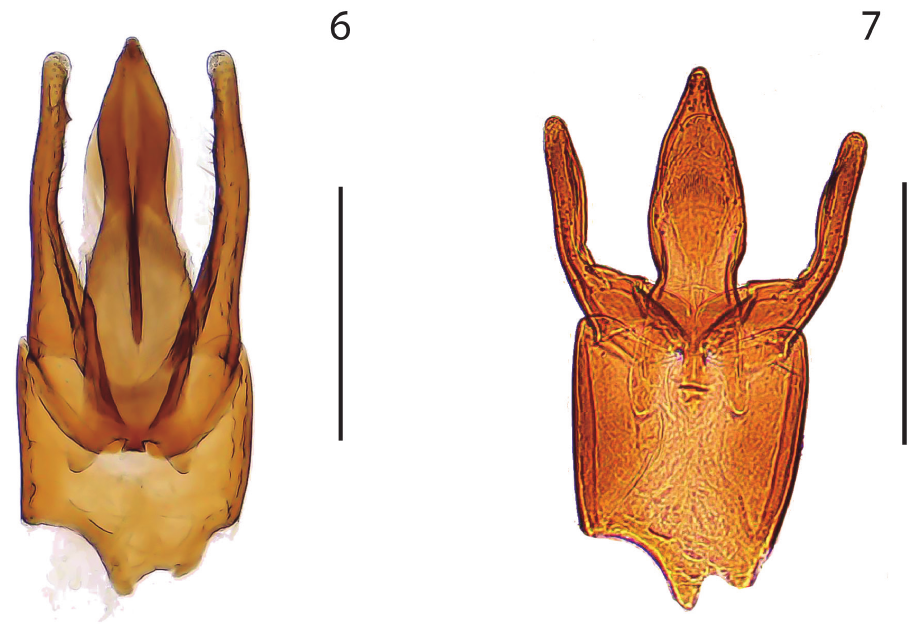
Figures 6–7 - Male genitalia of Stethelmis spp. ( 6 ) aedeagus of Stethelmis shepardi ; ( 7 ) aedeagus of Stethelmis kaszabi . Scale bars: Figs. 6–7: 0.25